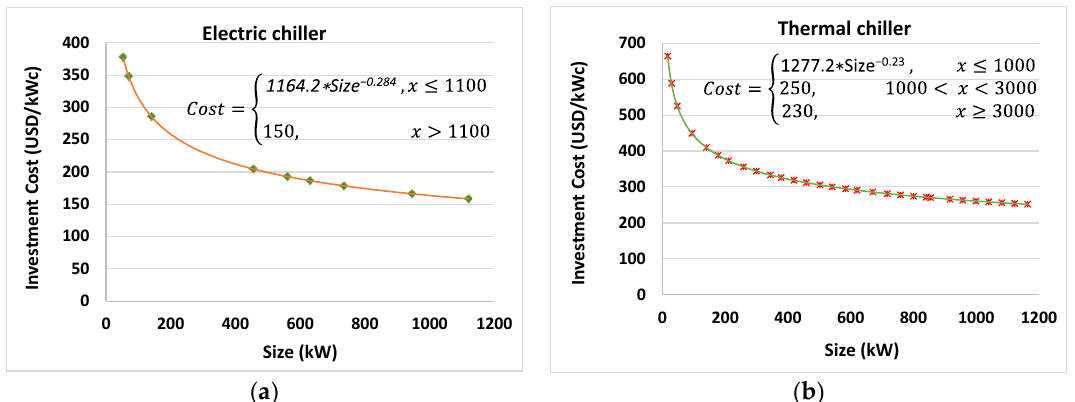
Figure 6. Initial cost of generic electric chillers ( a ) and thermal chillers ( b ) [11].